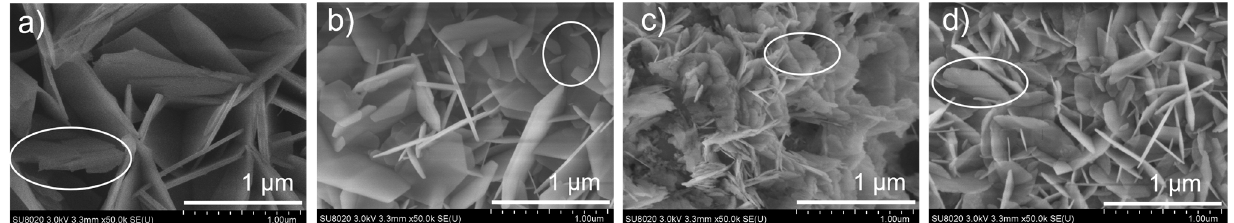
Figure 7. SEM images of surface ( a ) E1024, ( b ) E1124, ( c ) A1024, ( d ) A1124, after immersion in 0.1 M NaCl solution for 7 days.